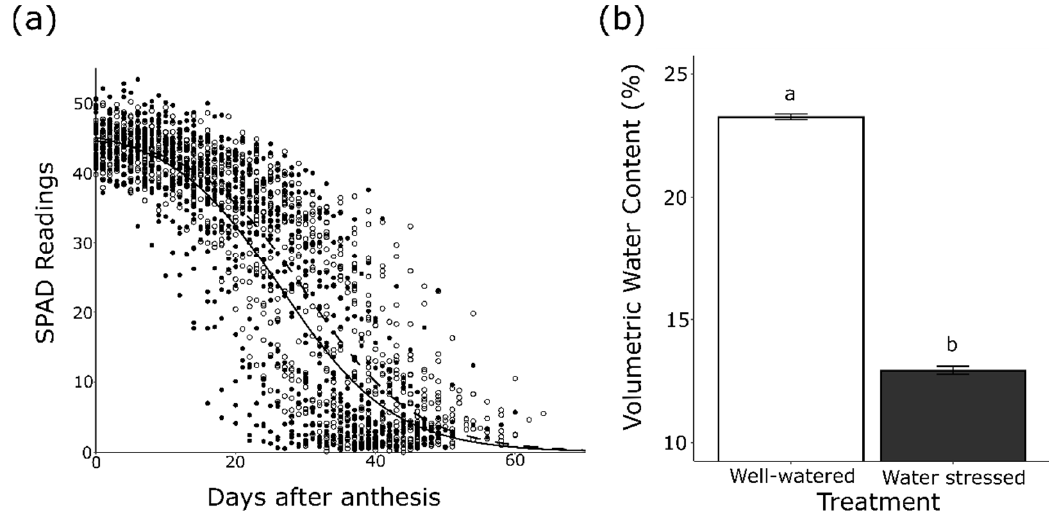
Figure 1. Effects of water stress imposed during plant growth. ( a ) The relationship between SPAD values and days after anthesis for experimental plants grown under well-watered (open circles) and water-stressed (filled circles) conditions. The dashed sigmoid curve represents pots grown under well-watered conditions and the solid sigmoid curve represents pots grown under water-stressed conditions. ( b ) The mean volumetric water content ( v / v ) of pots over the grain-filling period under well-watered and water-stressed treatments. Treatments that do not share a letter are significantly different. Error bars are standard error of the mean.